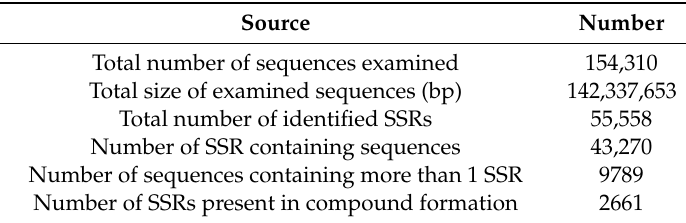
Table 4. Statistical summary of simple sequence repeats (SSRs) identified in avocado.